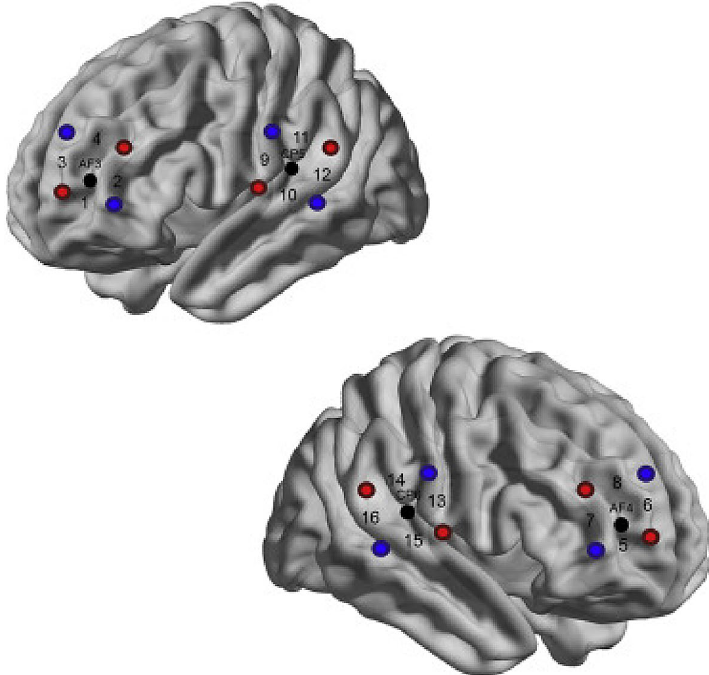
Figure 4. Cap configuration. Red circles illustrate sources and blue circles mark detectors. Channels between sources and detectors are marked by numbers 1–16. Black circles represent EEG 10–20 channel positions for orientation (Adapted from Nguyen et al. 2020a with